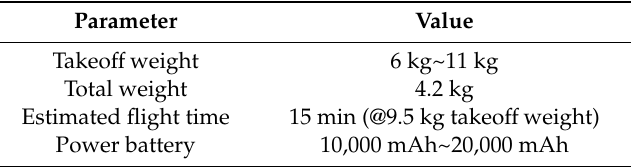
Table 3. Characteristics of the UAV.